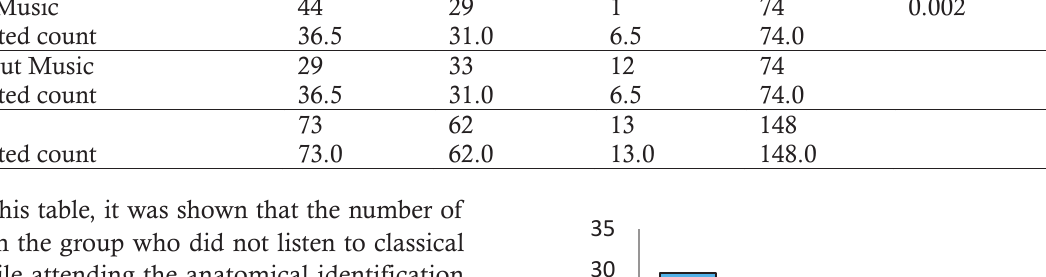
Figure 1. Student’s Stress Profile in